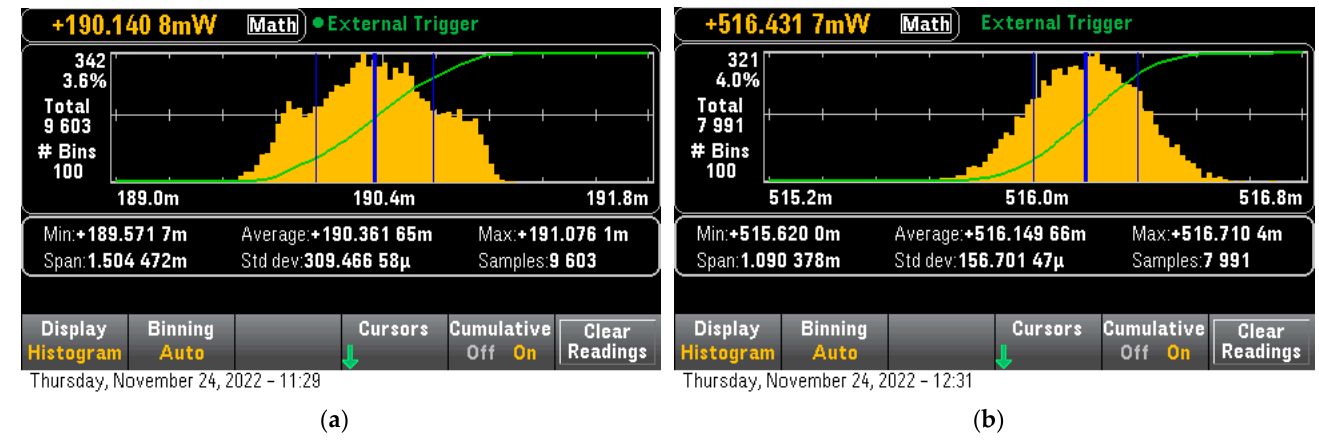
Figure 11. Uncompressed IPS Model Inference consumption ( a ) For ESP32, ( b ) For STM32H7. Table 4. BlueTooth IPS Model